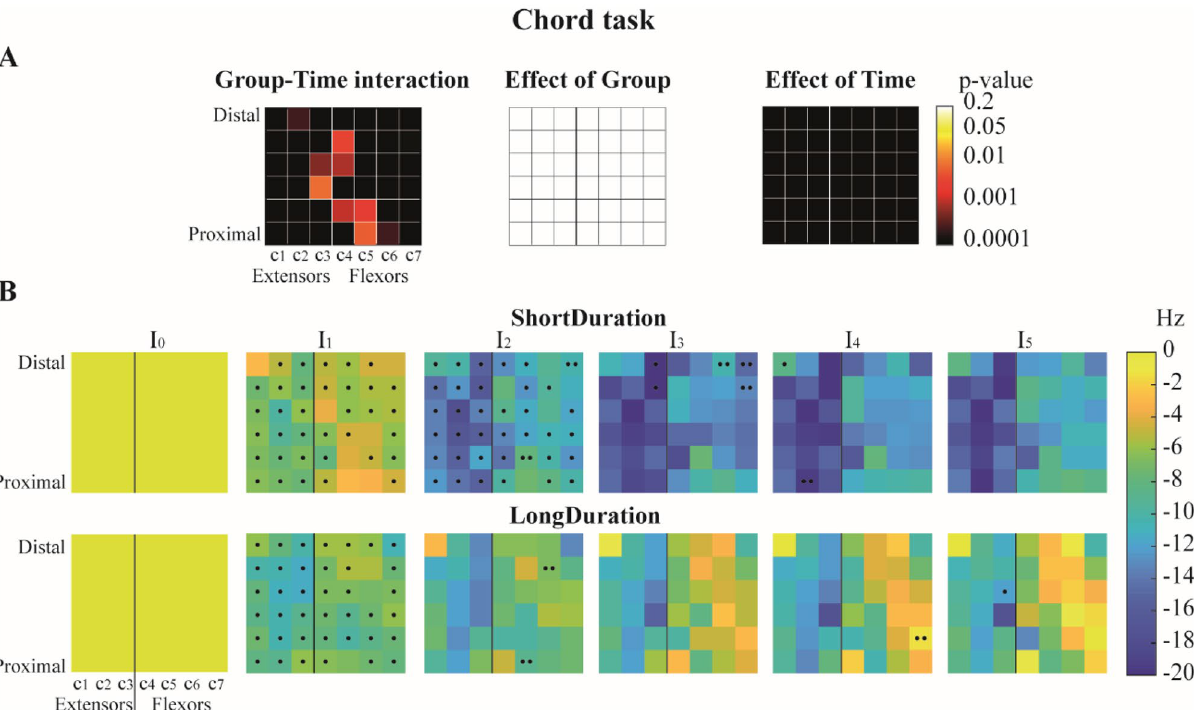
Figure 5. ( A ) colormap representation of ANOVA results’ p values for Group–Time interaction, main effects of Group, and Time for the Chord task. Columns of electrodes are labelled c1 to c7 as illustrated on the Fig. 8B. ( B ) Average change from baseline (I 0 ) representation of the participants’ EMG median frequency of the forearm muscles throughout the duration of the task (I 0:5 ), for the ShortDuration (superior panel) and LongDuration (inferior panel) groups. Note that ANOVA were performed on EMG median frequency values and that variation from baseline was for representation only. Dots indicate significant differences revealed by post-hoc analyses. One dot indicates a significant difference between time intervals I i and I i-1 for a given pair of electrode, while two dots indicates a significant difference between time intervals I i and I i−2 . For example, at time interval I 4 for the ShortDuration group, the dot on the left column ( c1 ) of the top row indicates a significant difference between the EMG median frequency at time intervals I 3 and I 4 , while the two dots on the second column ( c2 ) of the last row indicates a significant difference between the EMG median frequency at time intervals I 2 and I 4